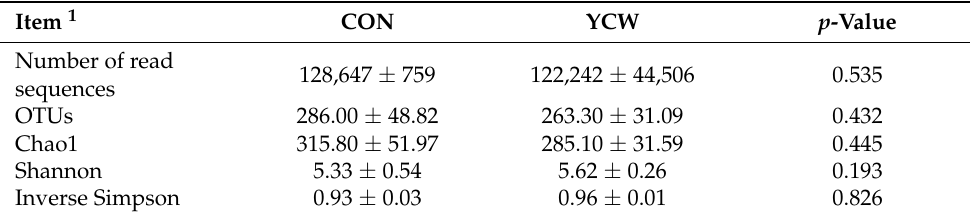
Table 6. Alpha diversity analysis for fecal microbiota of weaned pigs fed diets with or without dietary yeast cell wall.